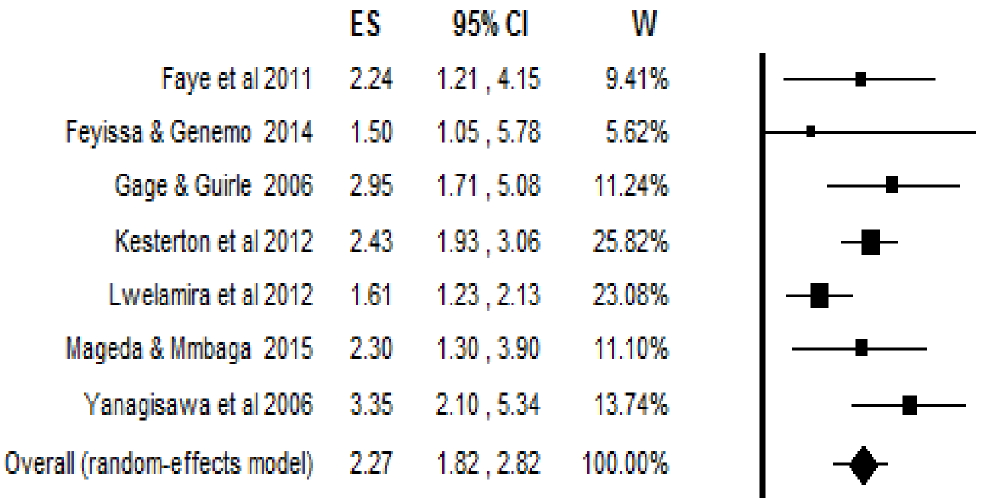
Fig 4. The effect of geographic access within 5km on delivery care use, effect sizes with 95% confidence interval.